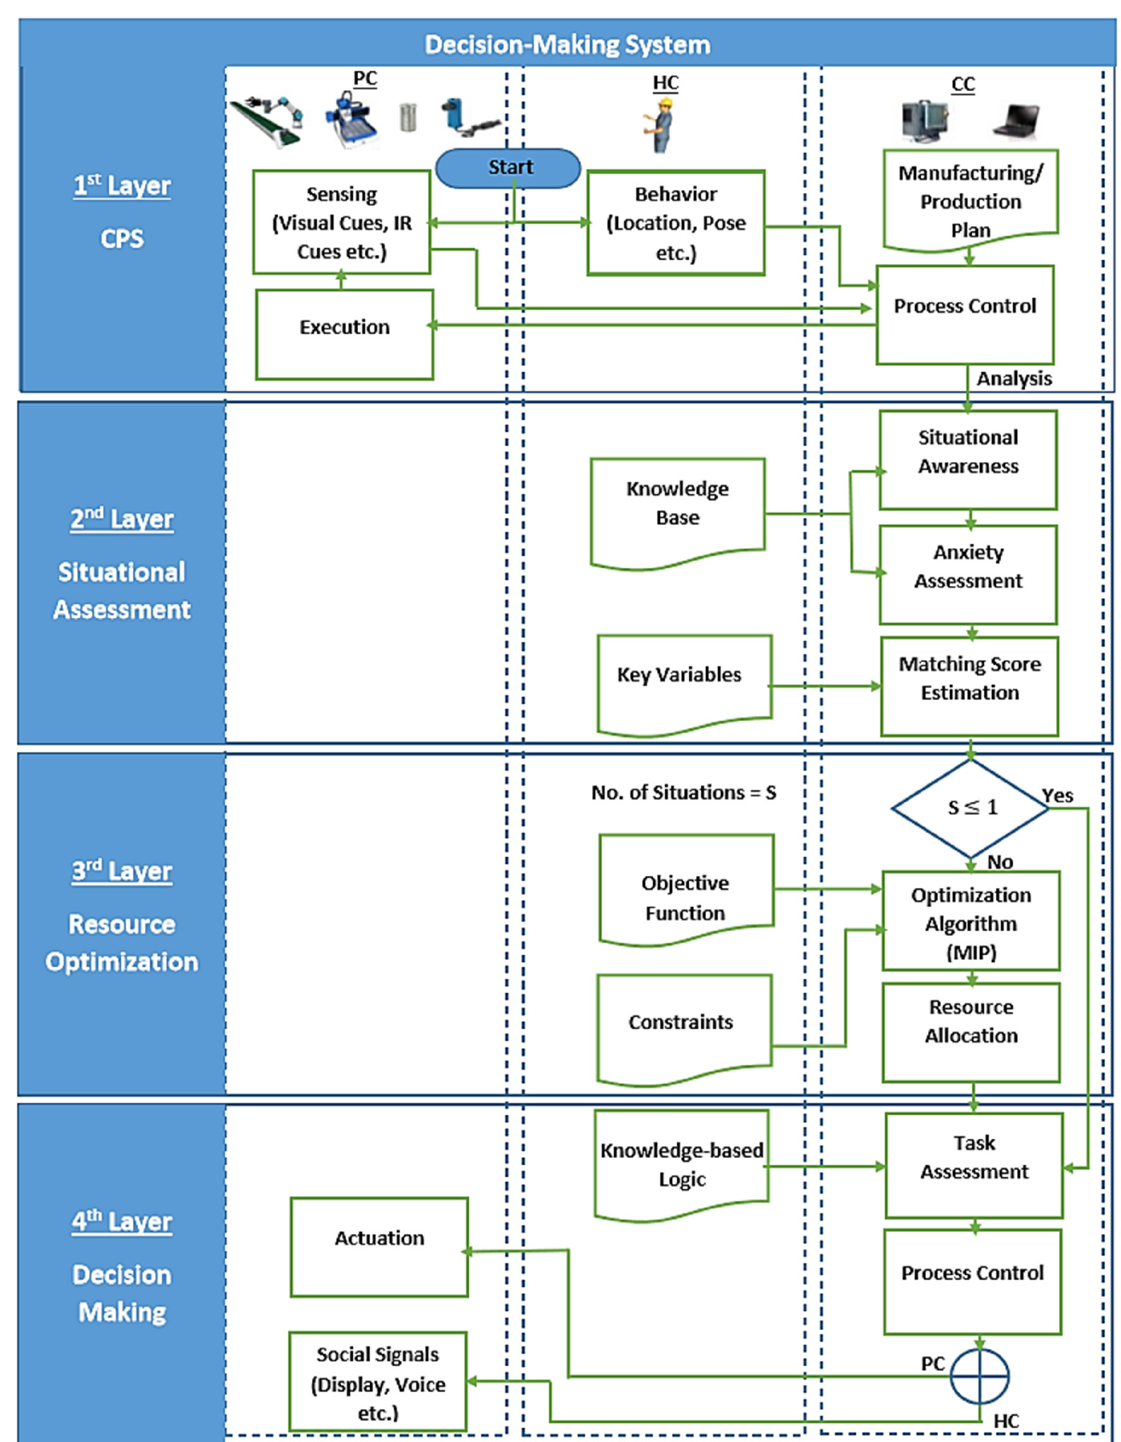
Figure 1. Decision-making connective framework for CPPS.